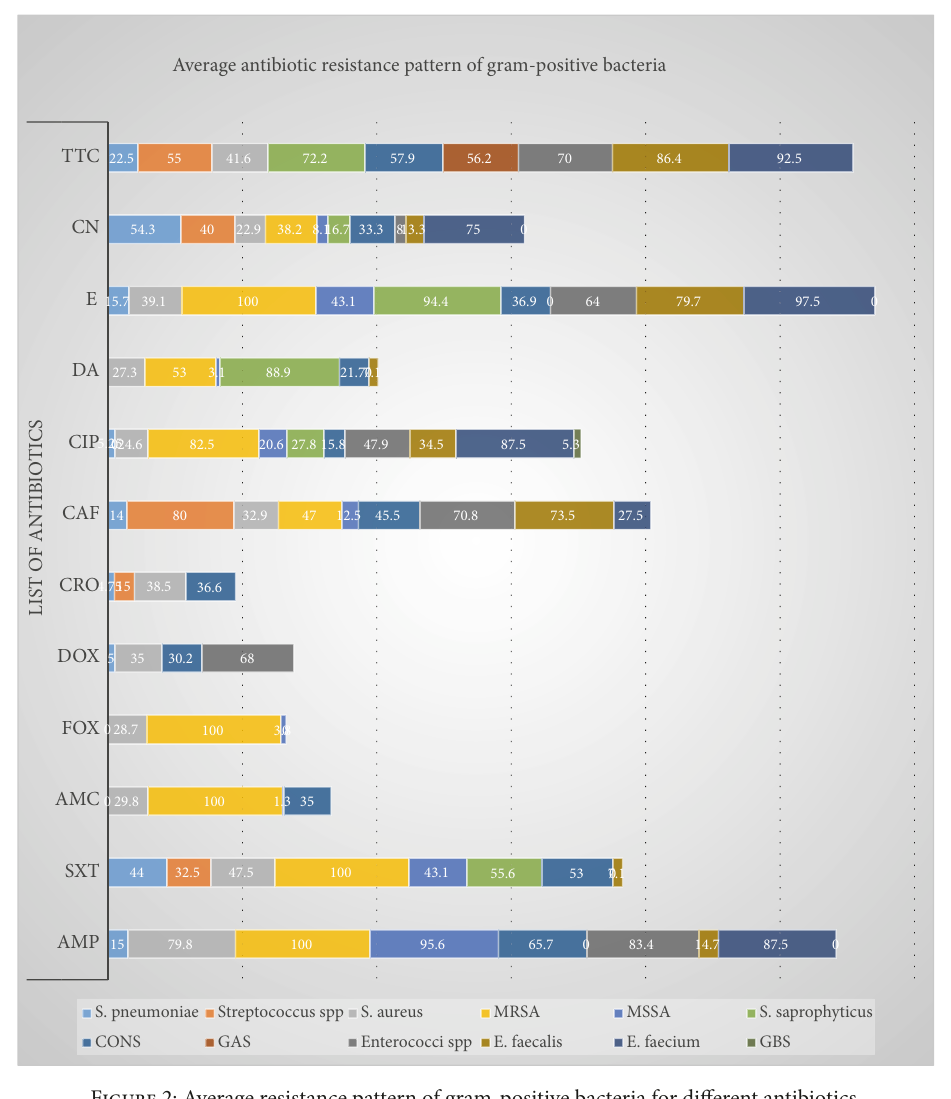
Figure 2: Average resistance pattern of gram-positive bacteria for different